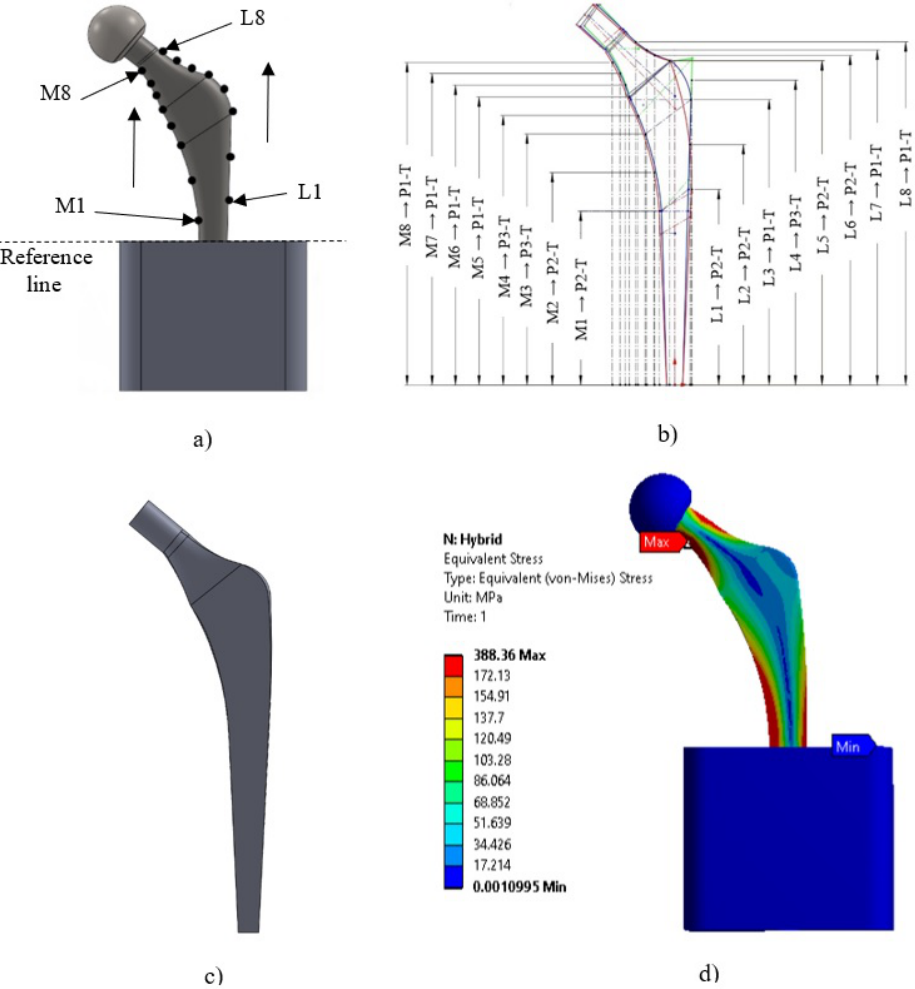
Figure 4. ( a ) Locations of 8 points in the medial side and 8 points in the lateral side of the implant. (The number of points increases upwards in both parts of the implant, M1 “Medial 1” and L1 “Lateral 1”). ( b ) Locations of the points that showed the best stress and strain results of the different stems evaluated, where (MX/LX → PX-T) represents the path assessed at each of the generated reference points (M1-M8 and L1-L8); P1, P2, and P3 represent the profile numbers; and the letter represents the type of cross-section (T = trapezoidal). ( c ) Design implant proposal. ( d ) Maximum stress with the hybrid profile using the load of activity 4 (Down stairs) and the stainless steel material